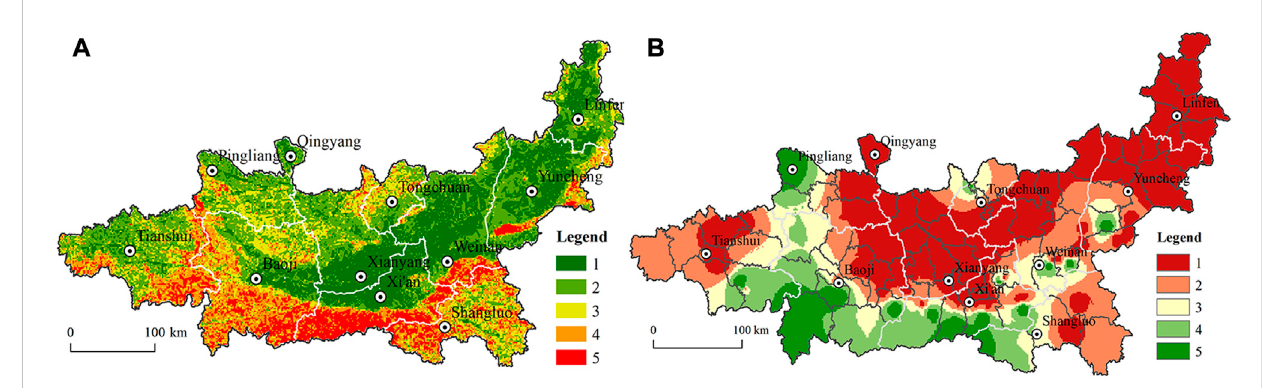
FIGURE 6 Spatial distribution of importance grades of ecological protection (A) and cultural and entertainment service (B) in GPUA (Grade 1 = lowest; Grade 5 =